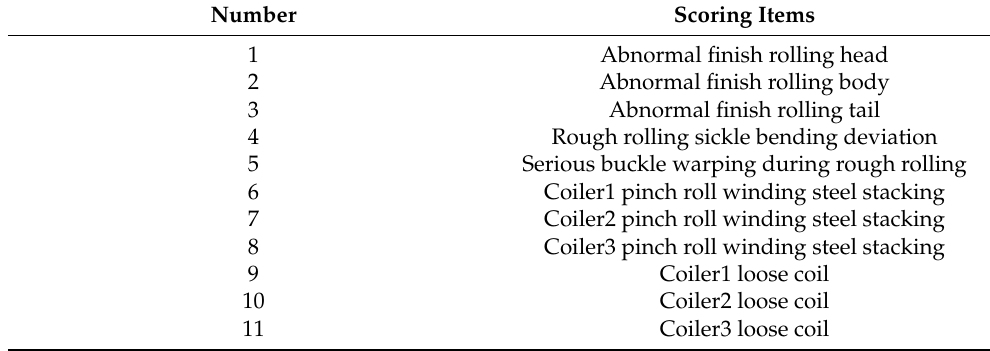
Table 1. Rolling stability score.